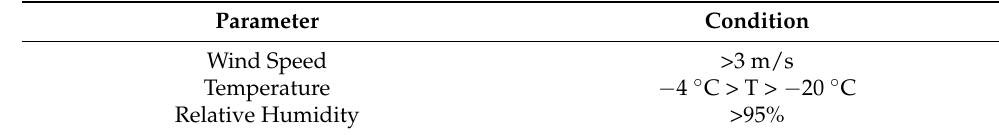
Table 1. Conditions for atmospheric icing (adopted from